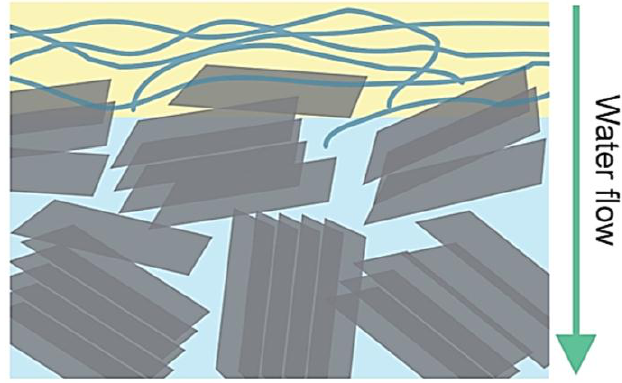
Figure 15. Schematic representation of PTFE/GNP:CNT electrochemical filter. Reprinted from [138], with permission from Royal Society of Chemistry.